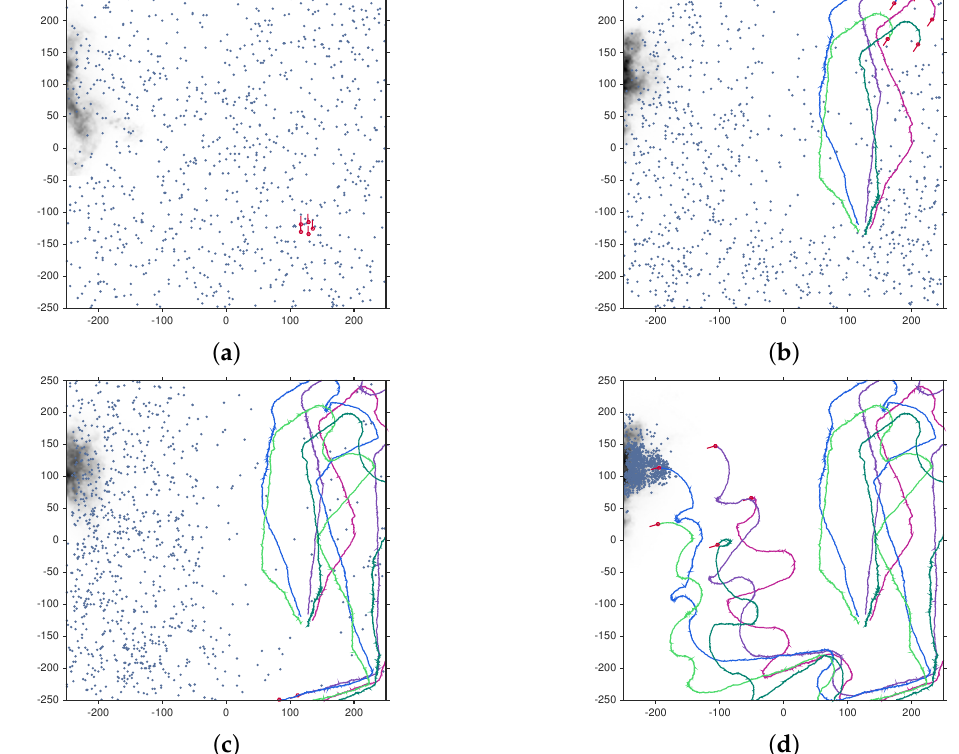
Figure 7. An illustrative run of the multi-robot search algorithm on the experimental dataset using N = 5 platforms. ( a – d ) show the positions and trajectories of the platforms at times k = 0, 10, 20 and 30, respectively. The plume from the experimental dataset can be seen in the top left of the search area, with darker areas representing higher concentrations.